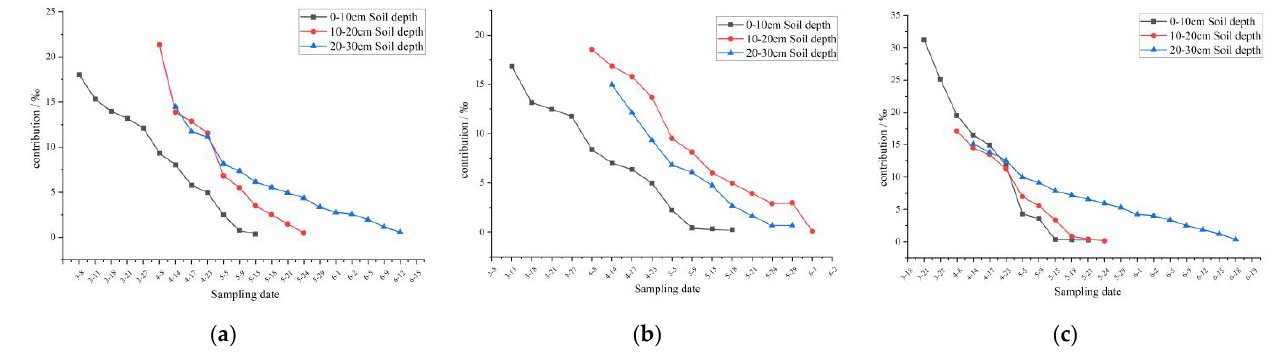
Figure 7. Contribution of snowmelt water to soil water at 10 cm soil layer ( a ), 30 cm soil layer ( b ), 50 cm soil layer ( c ). Table 7. Simulation equation of the dynamic process of the contribution of the snow depth to the soil water in the different soil layers.